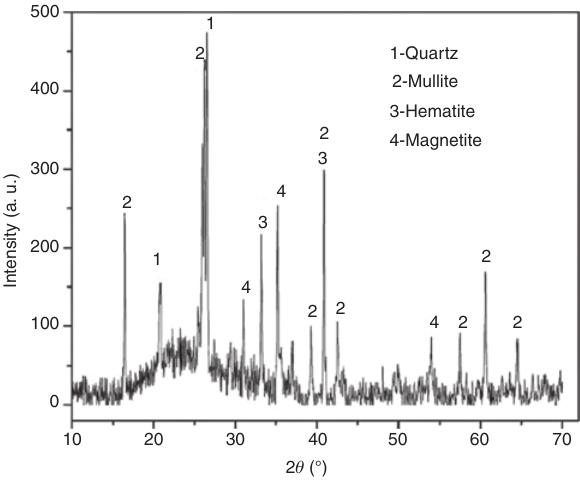
Figure 1: XRD pattern of fly ash.